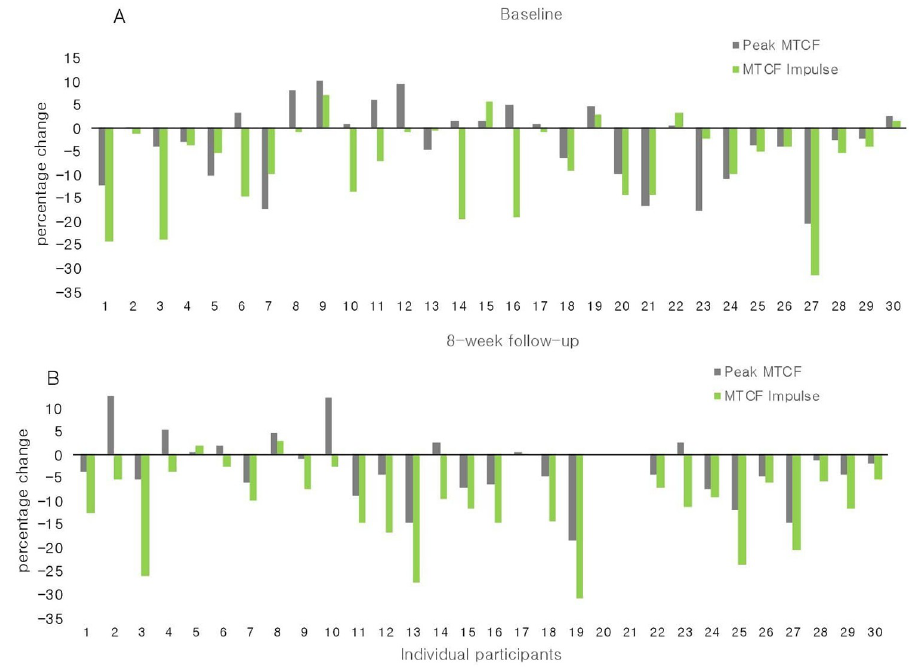
Fig 2. Percentage changes scores for individual participants for peak medial tibiofemoral joint contact force (MTCF) and MTCF impulse at week 0 (A) and week 8 (B). Negative values indicate a decrease in scores with wearing the brace, and positive values indicate an increase in score with wearing the brace. Missing data from two participants who did not return for MTCF assessment at week 8.